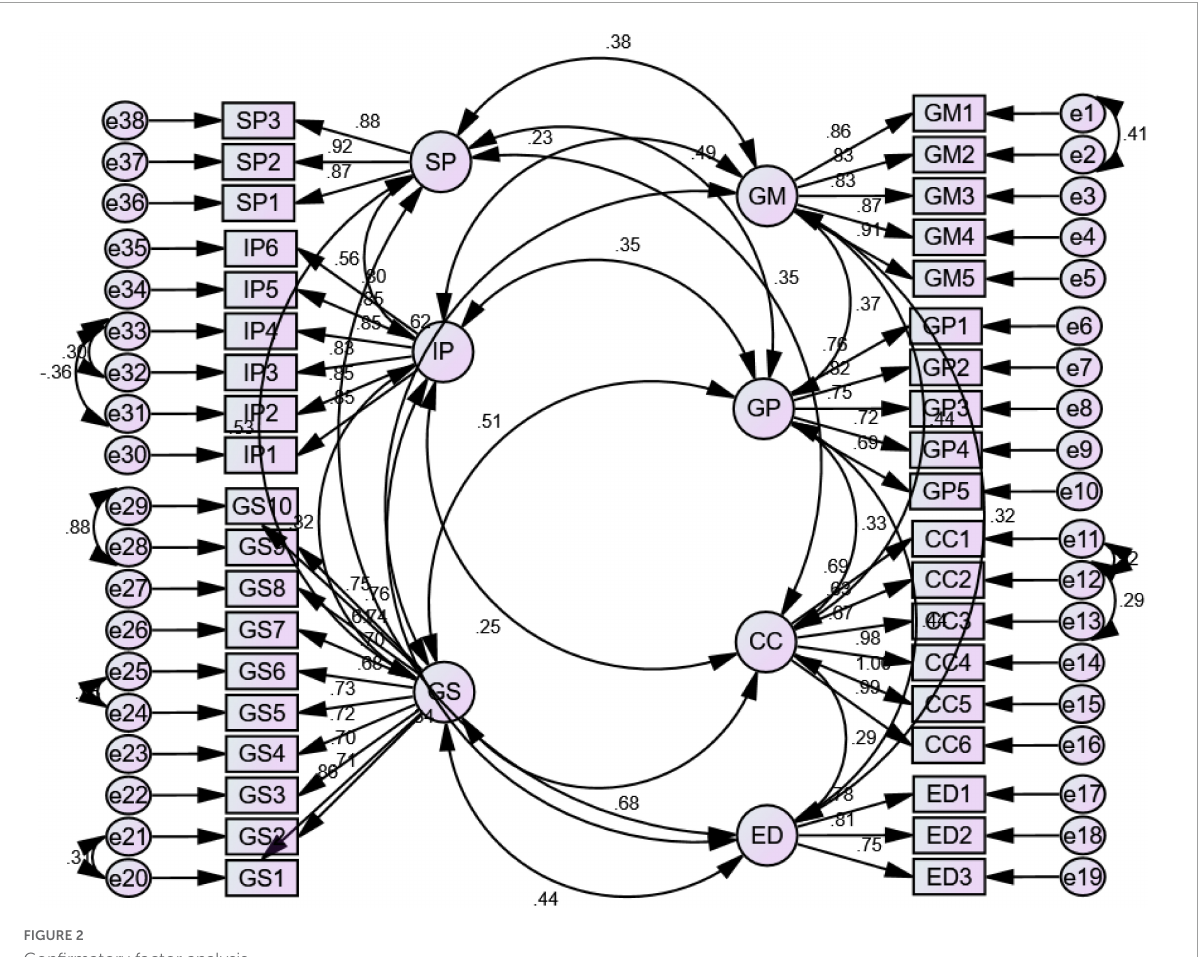
FIGURE2 Confirmatory factor